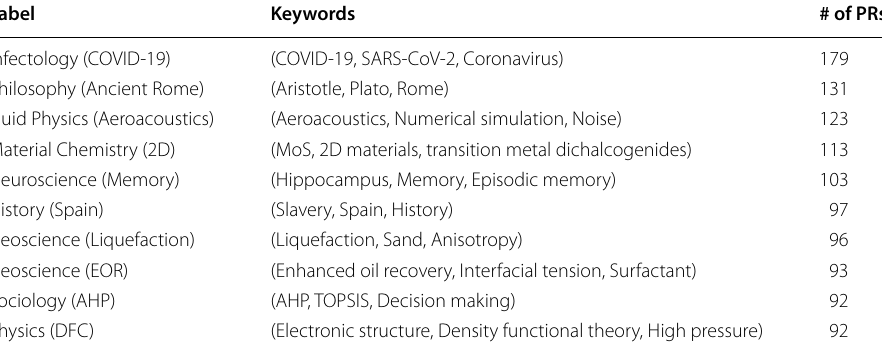
The table extended to the top 50 is presented in Table 13